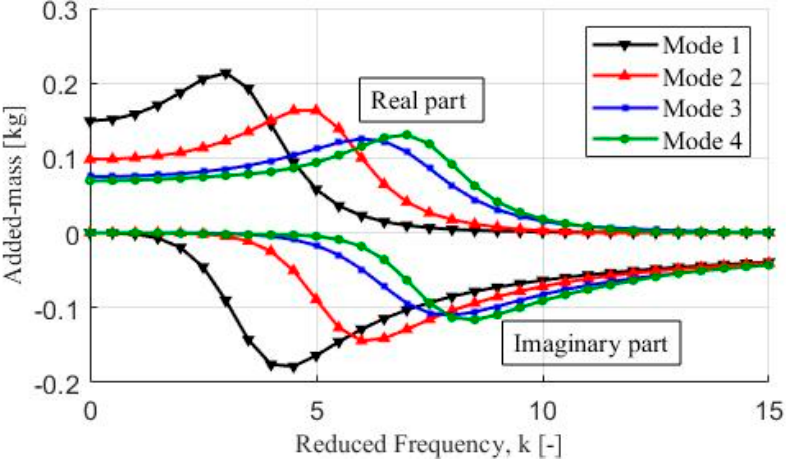
Figure 6. Added mass terms as function of reduced frequency of rectangular simply supported plate.